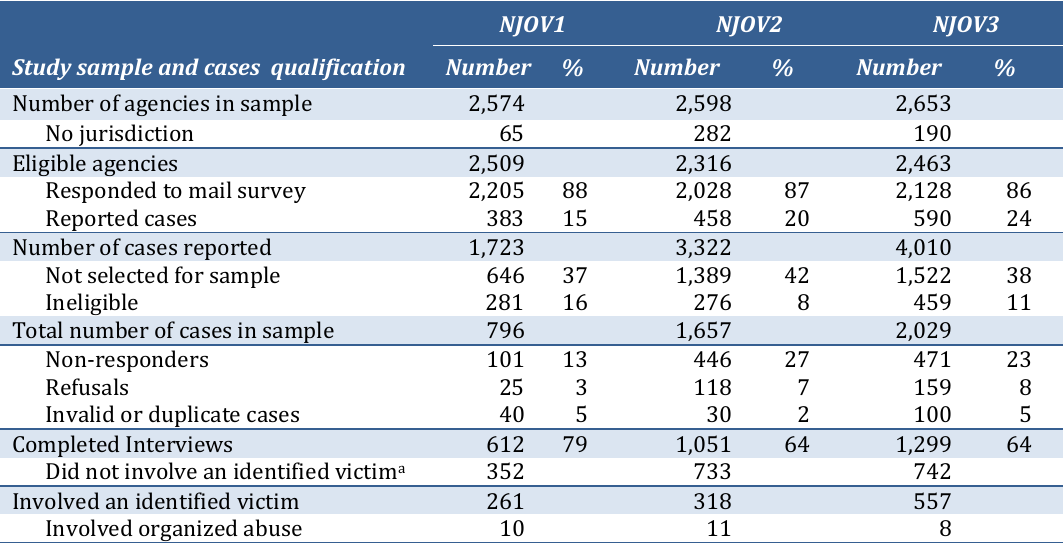
Table 1: Final dispositions and response rates for the 3 waves of the National Juvenile Online Victimization (NJOV) Study NJOV1 NJOV2